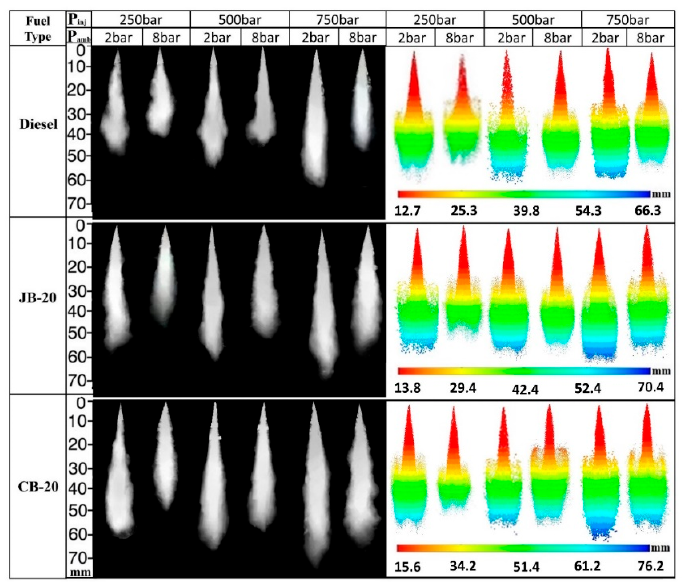
Figure 8. Experimental and simulated results for penetration length of diesel, JB-20, and CB-20 at 2-bar and 8-bar ambient pressures with IP of 250 bar, 500 bar, and 750 bar.